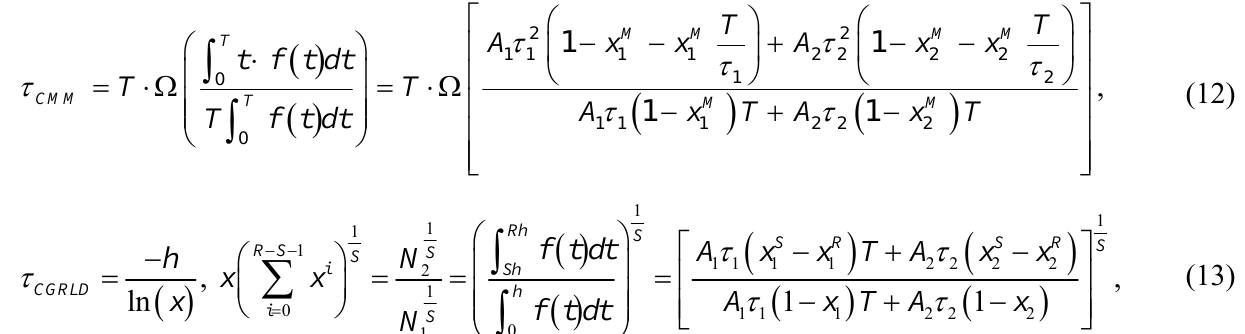
Figure 6. Average lifetime versus A